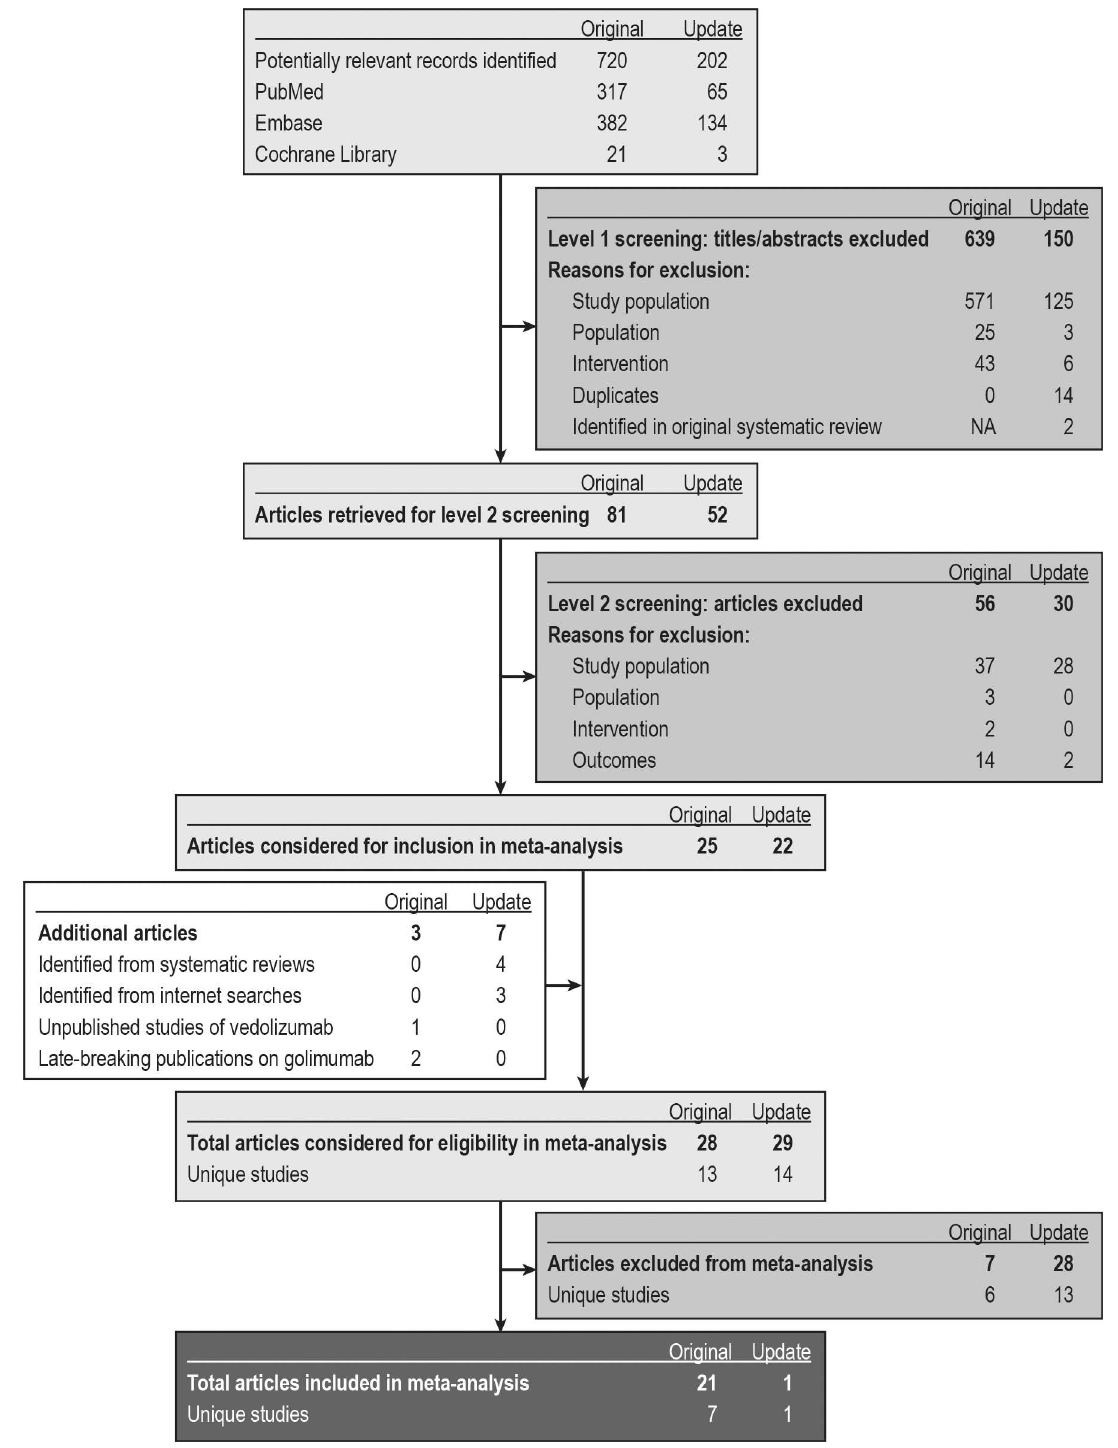
Fig 1. PRISMA diagram: identification and selection of sources. NA, not applicable; PRISMA, Preferred ReportingItems for Systematic Reviews and Meta-Analyses.